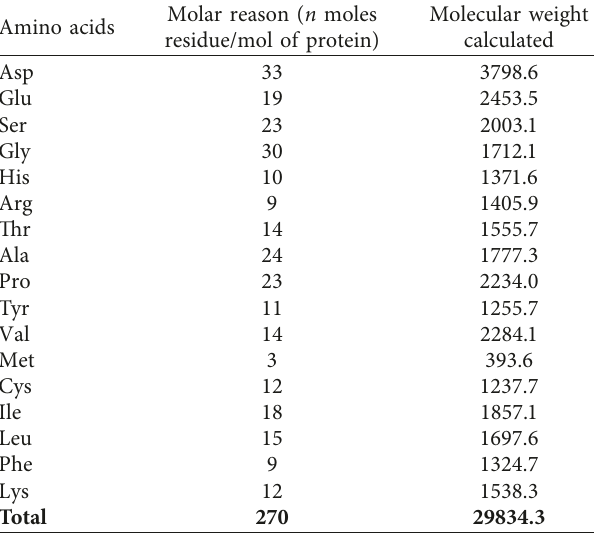
Table 1: Amino acid composition of the TLBpic